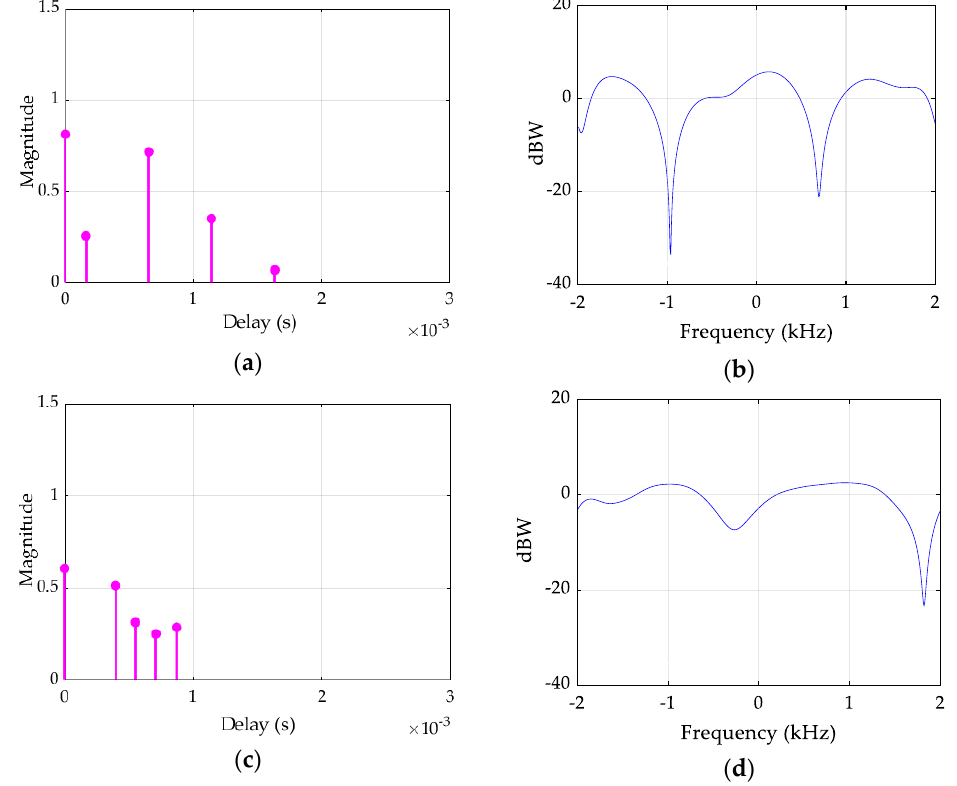
Figure 6. CIRs and CFRs of the UA channel for the first OFDM frame ( a , b ) and the fifth OFDM frame ( c , d ).